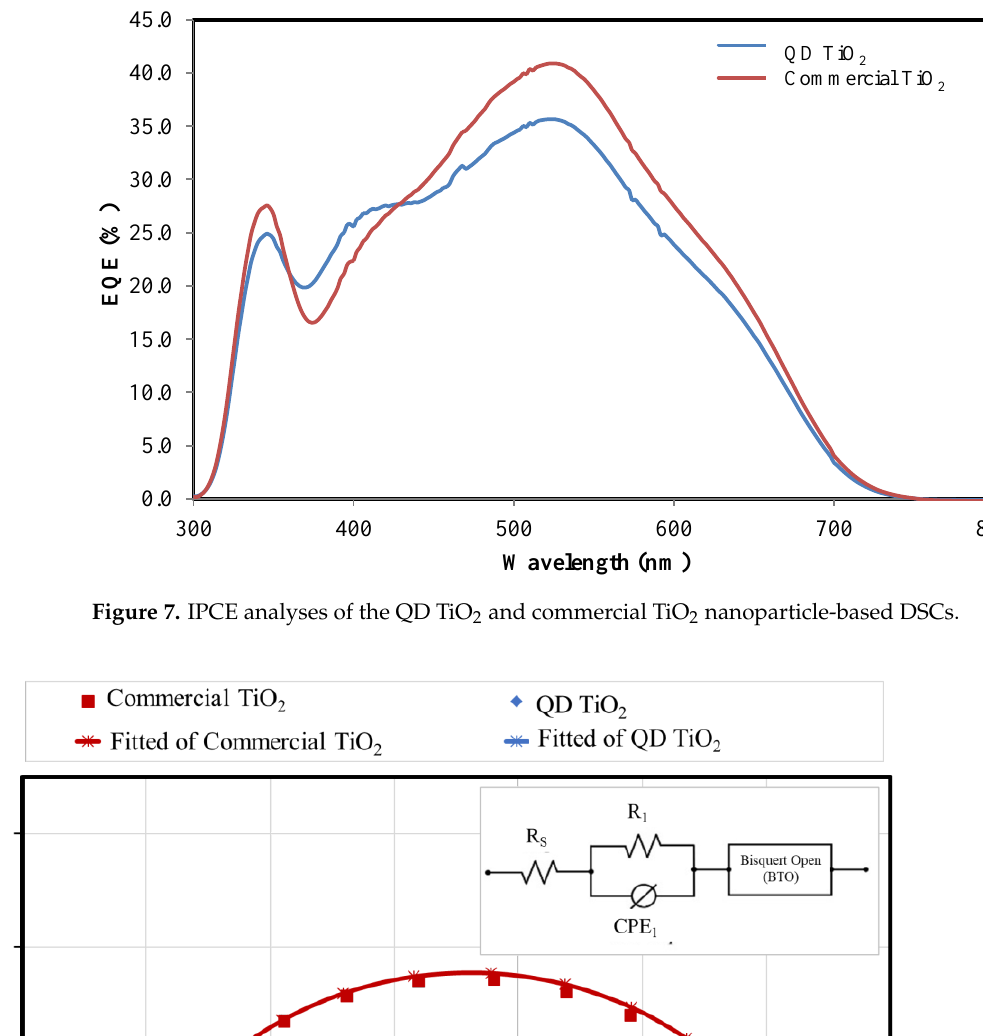
Figure 7. IPCE analyses of the QD TiO 2 and commercial TiO 2 nanoparticle-based DSCs.